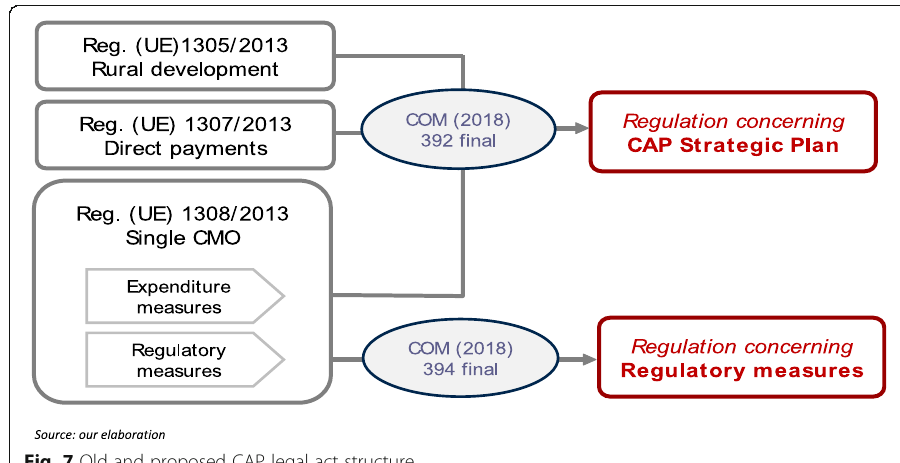
Fig. 7 Old and proposed CAP legal act